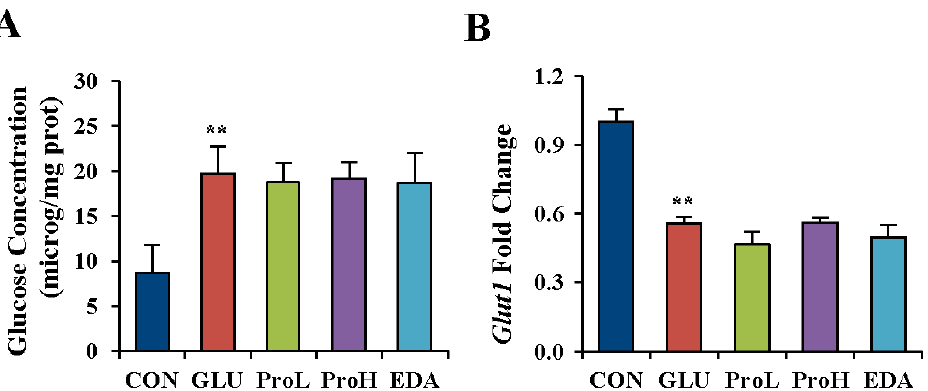
Figure 4. Proanthocyanidins had no effect on glucose concentration in high-glucose-treated eye of chick embryo. Glucose concentration ( A ) and GLUT1 gene expression ( B ) were detected in the eye of EDD 3.5 chick embryo. Values were expressed as mean ± SD in each group ( n = 10). ** p < 0.01 vs. control. CON: control, GLU: high glucose, ProL: 1 nmol/egg proanthocyanidins, ProH: 10 nmol/egg proanthocyanidins, EDA: edaravone.